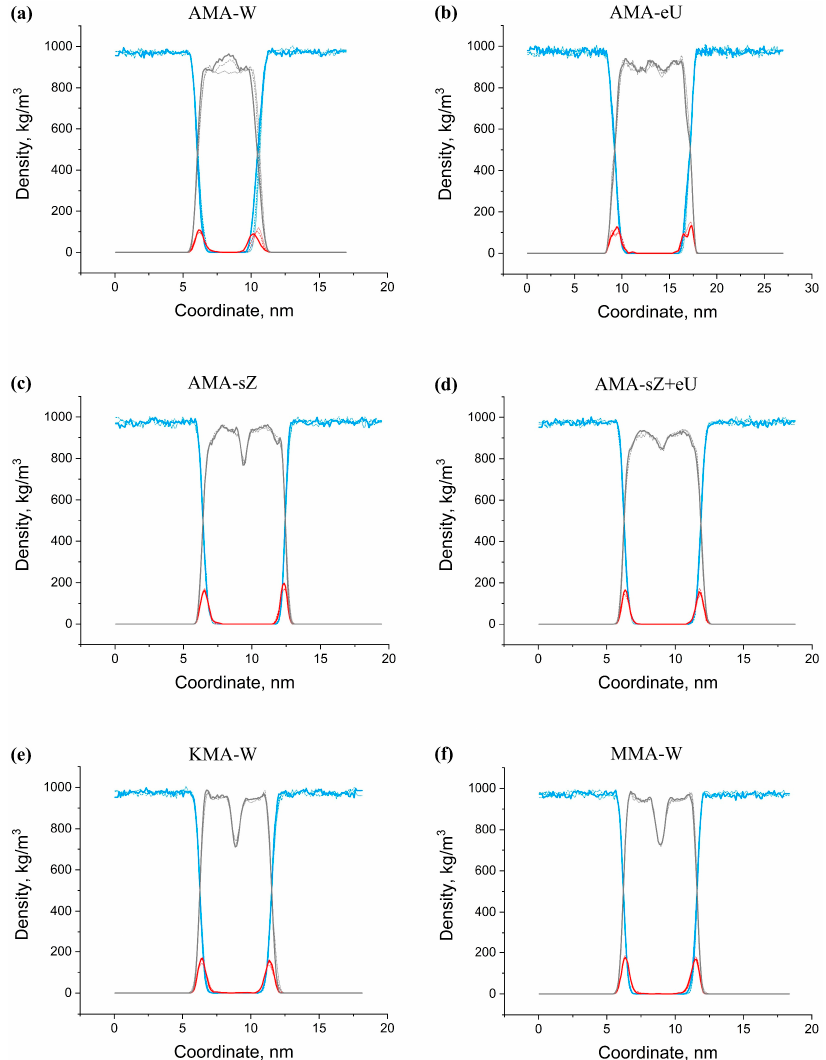
Figure 9. Density profiles in the single-component membranes: water (blue line); oxygen atoms (red line); all atoms of MA (gray line) at 100 ns (dotted line) 200 ns (dashed line); 300 ns (solid line). Membranes: ( a ) AMA-W, ( b ) AMA-eU, ( c ) AMA-sZ, ( d ) AMA-sZ+eU, ( e ) KMA-W, ( f ) MMA-W.